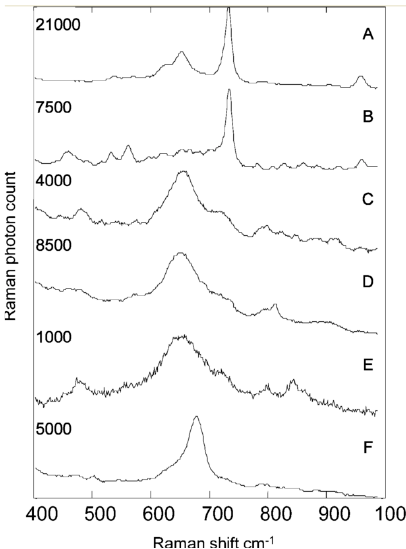
Figure 2. Typical unprocessed SERS spectra showing examples from UTI isolates. Each spectrum took 10 s to collect. ( A ) Enterococcus spp .; ( B ) P. mirabilis ; ( C ) E. coli ; ( D ) K. pneumoniae ; ( E ) K. oxytoca ; (F) C. freundii . The maximum Raman photon count for each spectrum is given on the left. Counts on the order of thousands and tens of thousands clearly indicate that these spectra result from the SERS process rather than normal Raman scattering. Reprinted with permission from [109], Copyright © 2004 American Chemical Society.